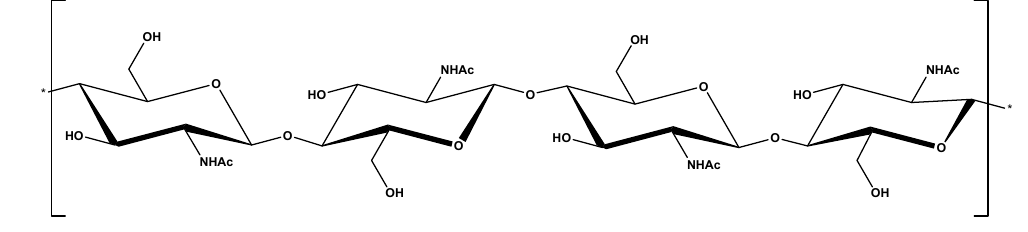
Figure 2. Chemical structure of chitin.